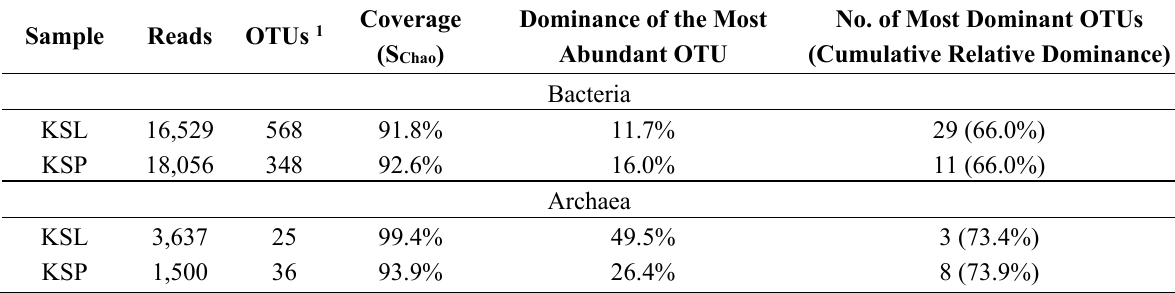
Figure 1. Rarefaction curves of the operational taxonomic units (OTUs) in two water wells (KSL and KSP) of the Lake Karla Basin, Greece. Table 1. Pyrosequencing results of the 16S rRNA gene in two water wells (KSL and KSP) of the Lake Karla Basin, Greece. OTUs: operational taxonomic